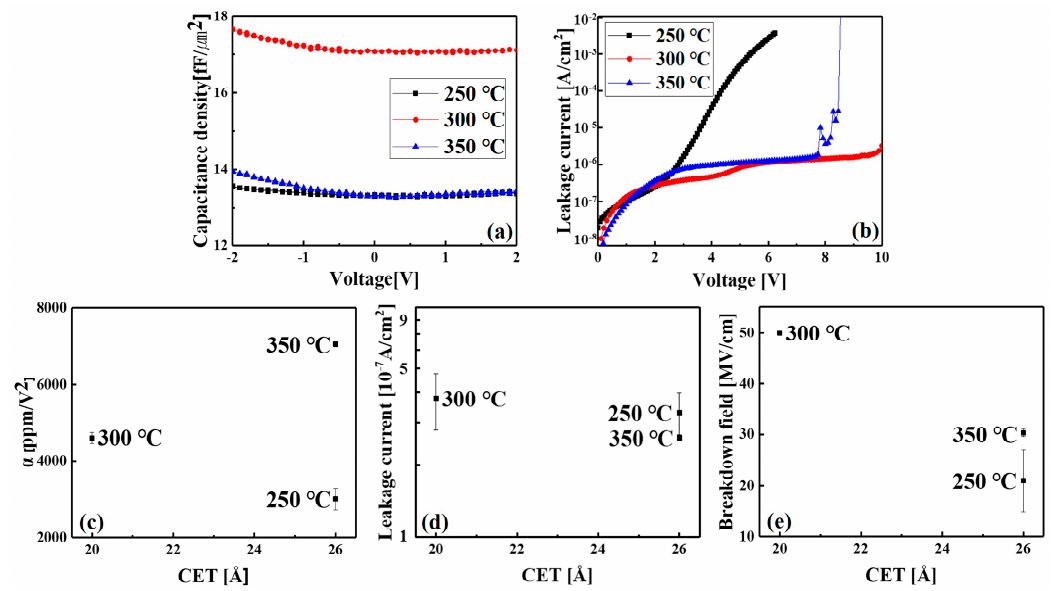
Figure 6. ( a ) Normalized capacitance and ( b ) J–V curves of TiN/ZrO 2 /TiN metal-insulator-metal (MIM) capacitors containing ZrO 2 films deposited at different growth temperatures. ( c ) Log–log relationship between the quadratic voltage coefficient ( α ) and capacitance density in the MIM capacitors. Comparison of ( d ) leakage current density and ( e ) breakdown field as a function of capacitance equivalent thickness. For the J–V measurements, the applied voltage was up to 10 V; breakdown occurred over 10 V in the case of 300 °C.